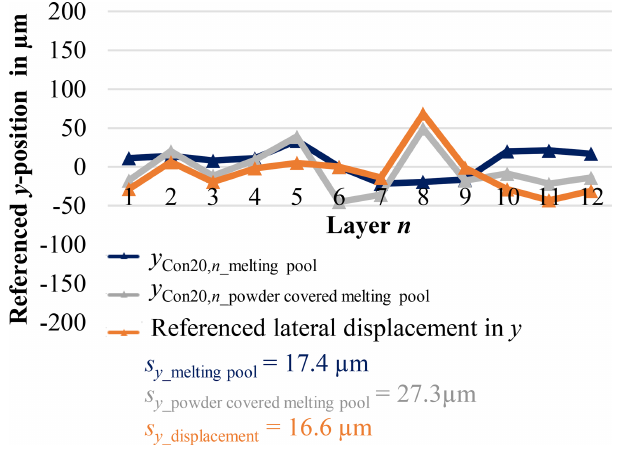
Figure 14. Evaluation of lateral displacement in y by comparison of melting pool and powder-covered contour positions (Con 20